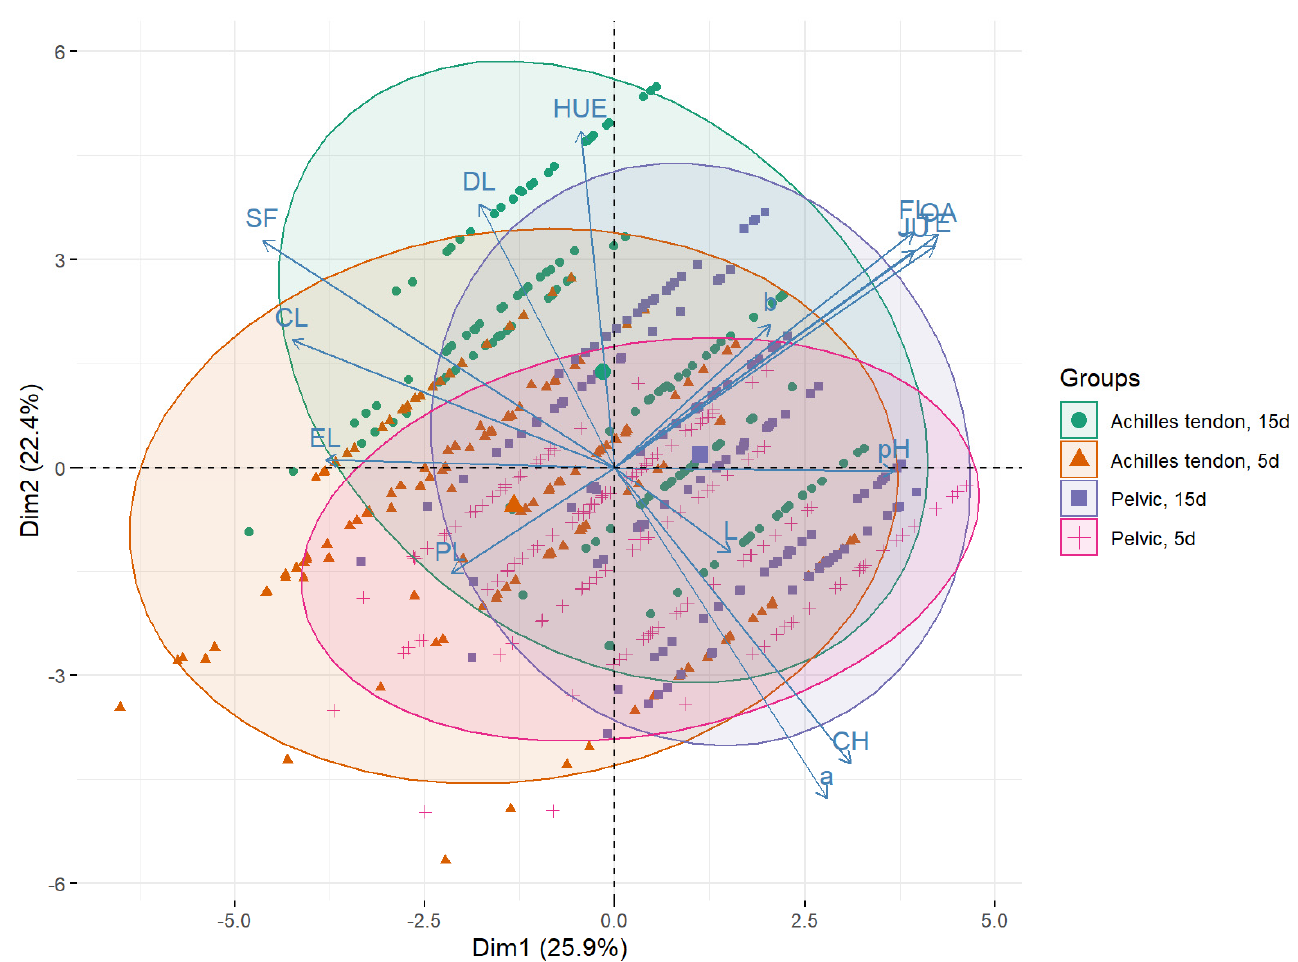
Figure 3. Score plot of meat quality data of Nellore bulls in the multivariate space defined by principal component analysis. PC1 “tenderness” (explained variance: 25.9%) × PC2 “meat color” (explained variance: 22.4%). Group symbols represent both the carcass-suspension method and meat aging period, respectively: ● (Achilles tendon; 15 days), ▲ (Achilles tendon; 5 days), ■ (Pelvic, 15 days), + (Pelvic, 5 days). The centroid value of each treatment is represented by a larger shape size.